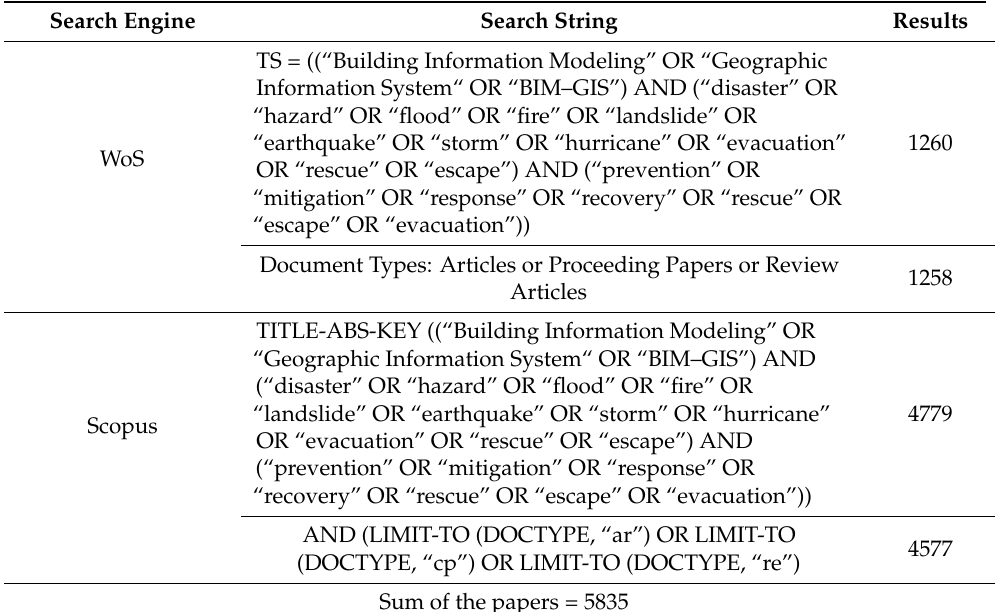
Table 2. Search Strings and Documents Search